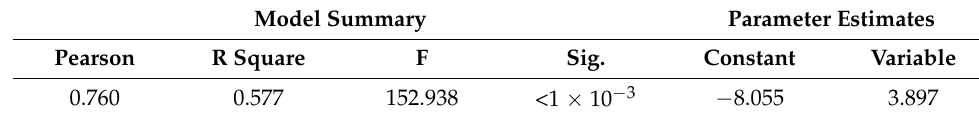
Table 8. Correlation between the number of partners and number of publications.